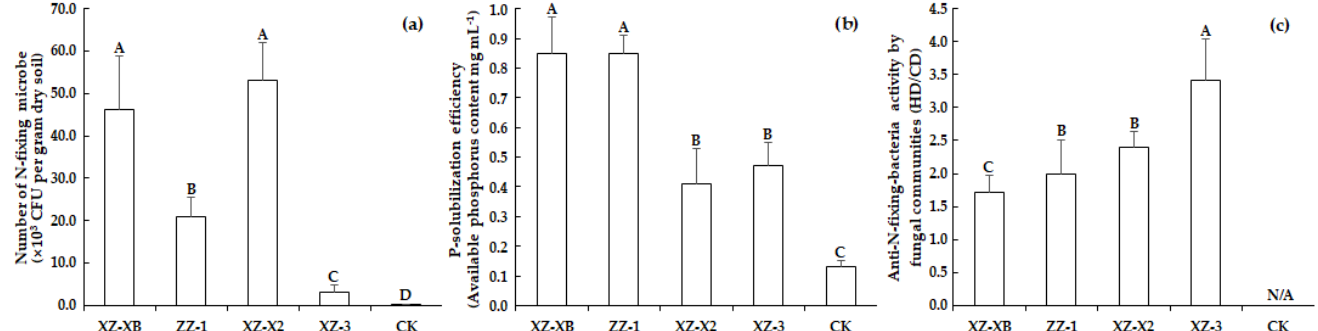
Figure 1. Variations of the rhizosphere soil content nitrogen-fixing microbe numbers ( a ), P-solubilization efficiency of the soil microbes ( b ) and anti-N-fixing-bacteria activity by fungal communities ( c ) between different ramie germplasms. Different capital letters within each measured trait indicate the least significant differences at a p < 0.01 level. N/A means not available. XZ-XB, Xiangzhu XB; ZZ-1, Zhongzhu 1; XZ-X2, Xiangzhu X2; XZ-3, Xiangzhu 3. CK is the control without ramie cultivation. HD/CD represents the halo zone diameter/colony diameter that measured in the antagonistic